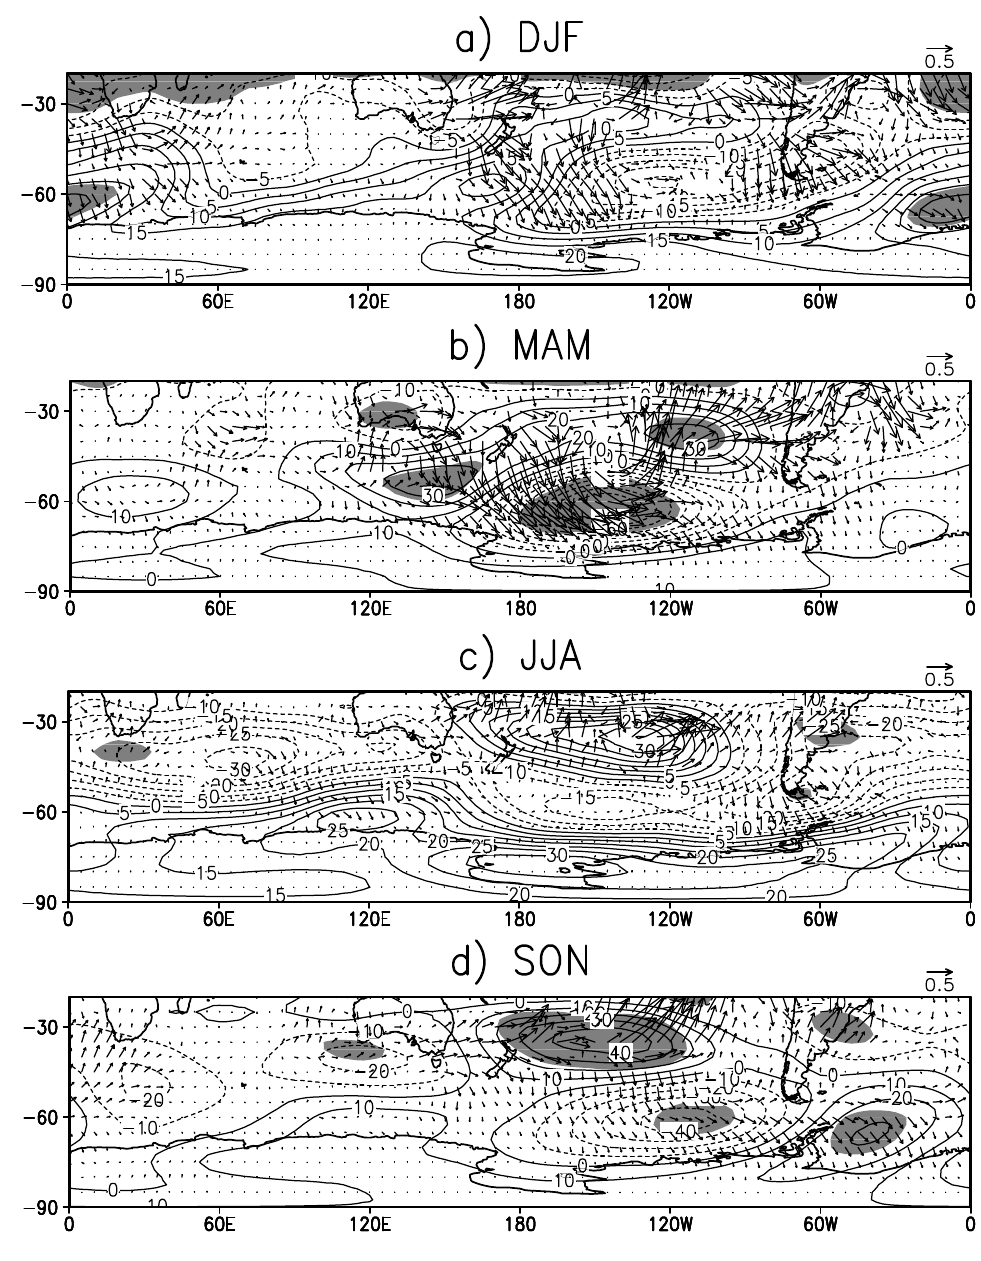
Fig. 8. Same as Fig. 7, but for the La Ni˜na